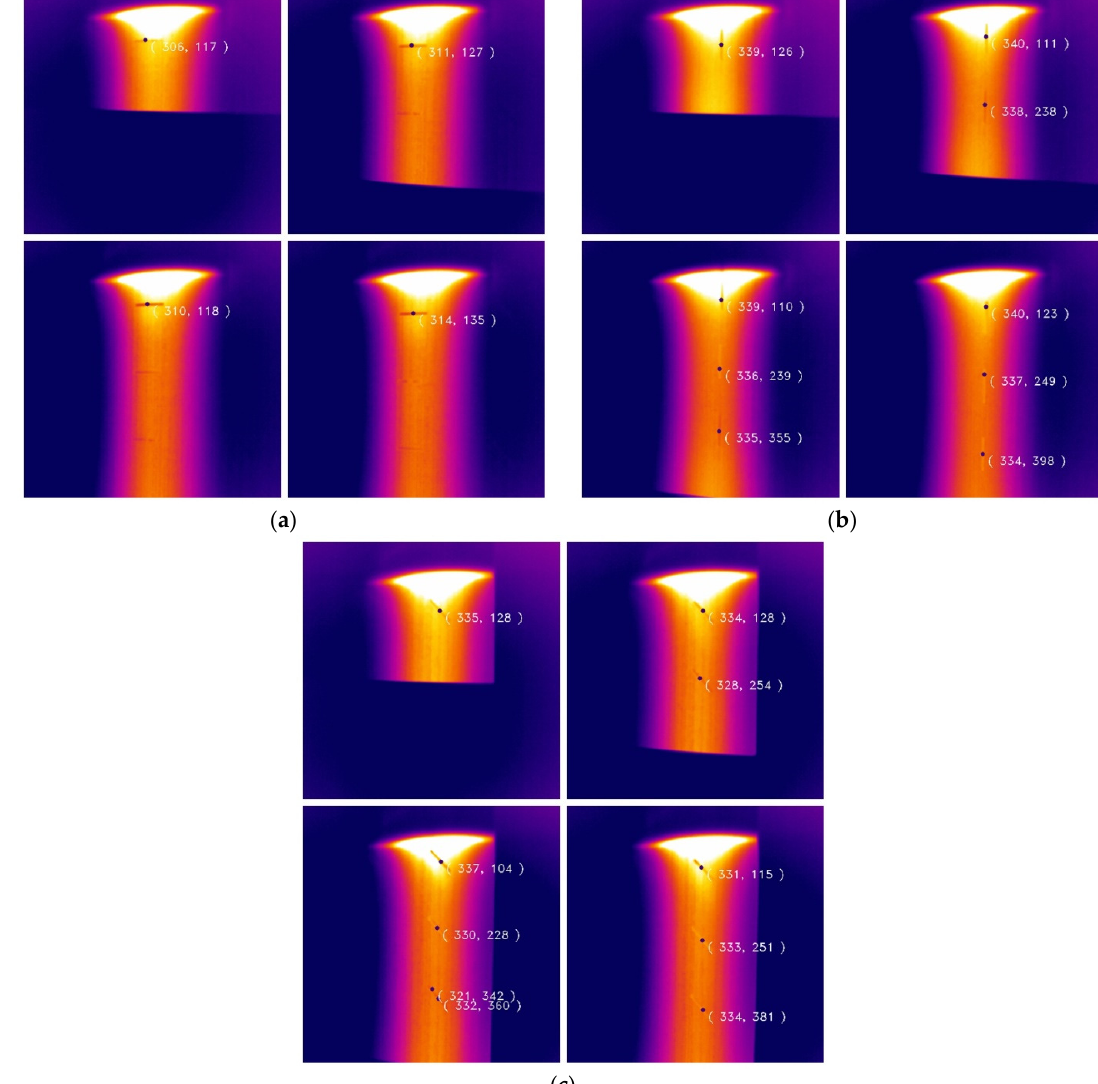
Figure 11. Detection results of cracks in different directions: ( a ) 0° fracture crack detection; ( b ) 90° fracture crack detection; ( c ) 45° fracture crack detection.